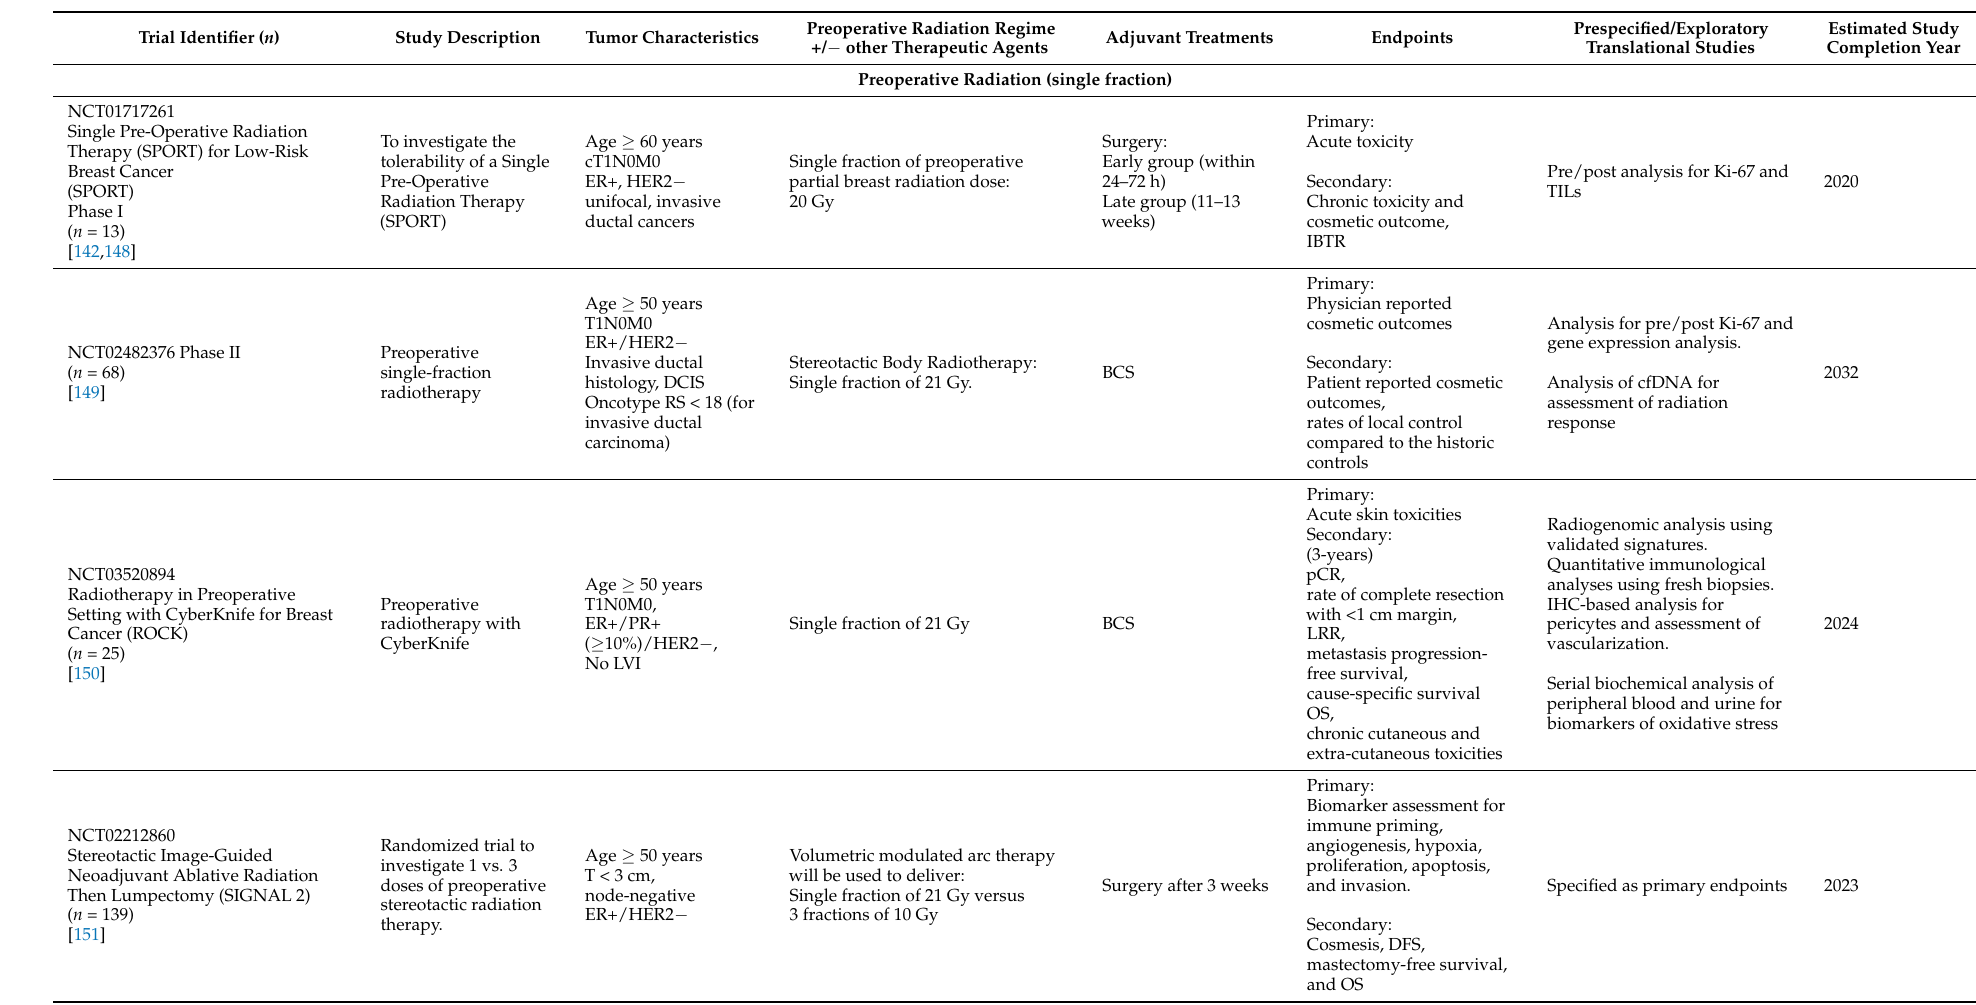
Table 2. Ongoing clinical trials investigating preoperative radiation therapy in early-stage invasive breast